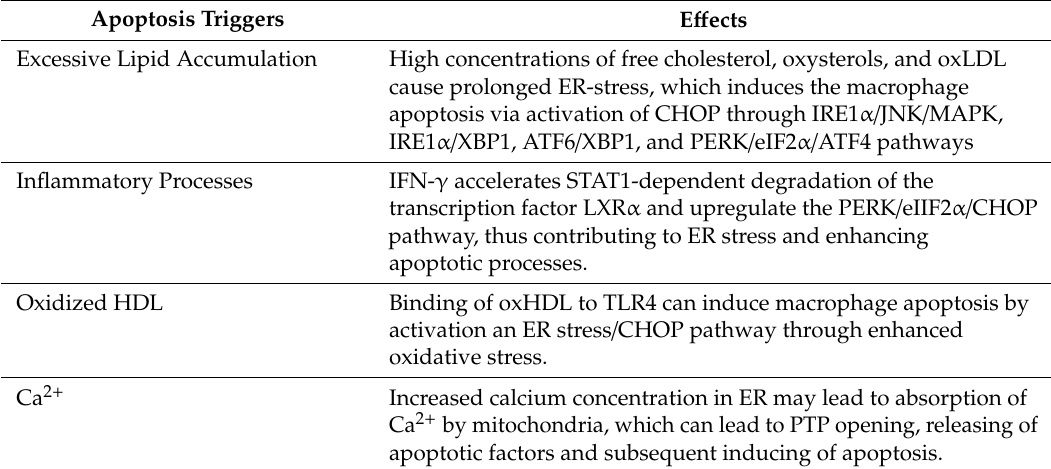
Table 2. Role of the endoplasmic reticulum stress in activation of apoptotic cell death pathways. Apoptosis